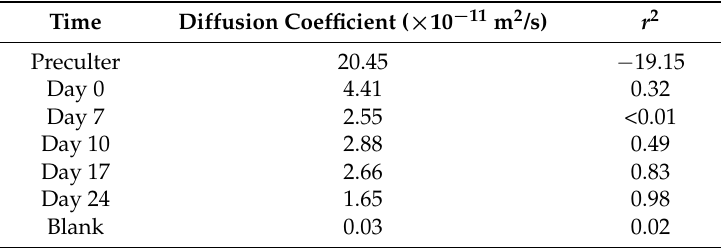
Table 3. Results of the calculated diffusion coefficient with the numerical simulation and the coefficient of determination ( r 2 ) regarding the experimental data. The diffusion of fluorescein sodium salt through the ftSEs at different cultivation times was